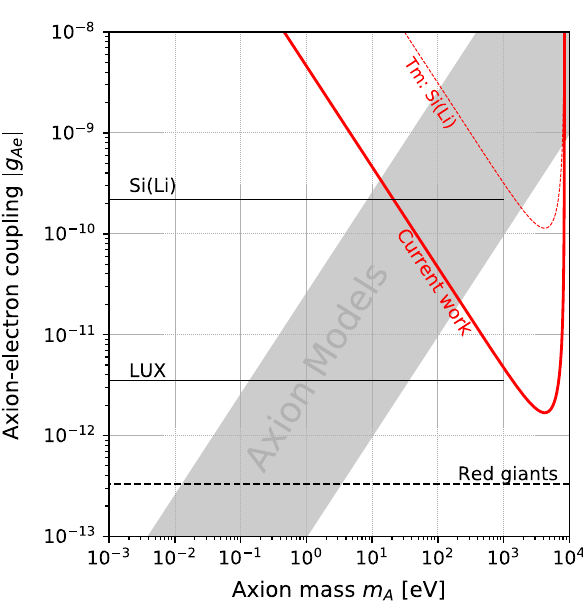
Fig. 5 Axion–electron coupling g Ae limits obtained in current work in comparison with other experiments (axio-electric effect on Si [43], LUX [44]) and astrophysical bounds (red giant cooling rate [45])